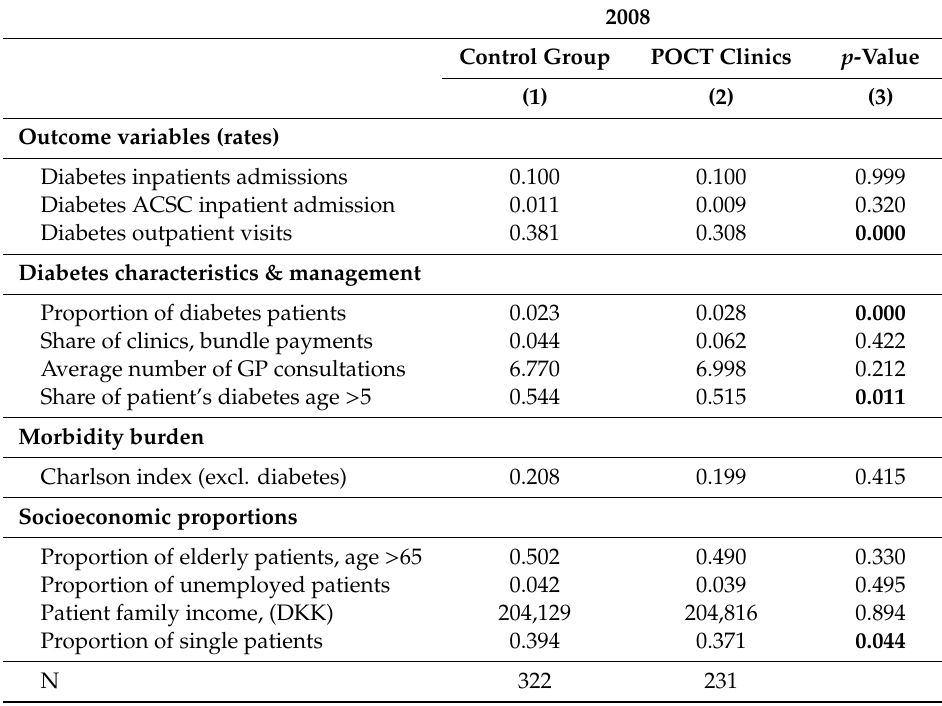
Table 5. Descriptive clinic characteristics for the treatment and control groups before the